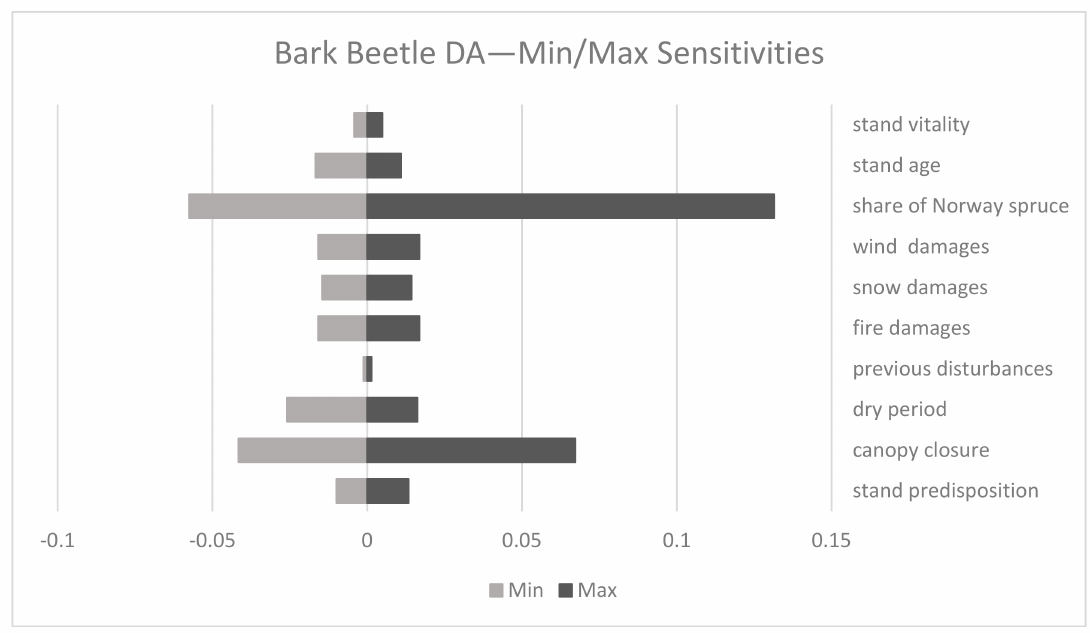
Figure 4. Sensitivity of each node of the bark beetle damage submodel. “Share of Norway spruce” shows the highest sensitivities (Min = − 0.058; Max =